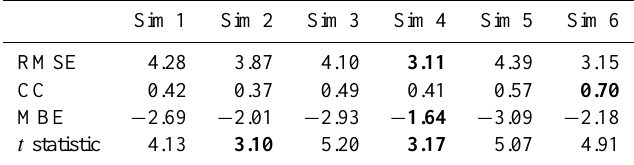
The best number for each statistical parameter is written in bold.